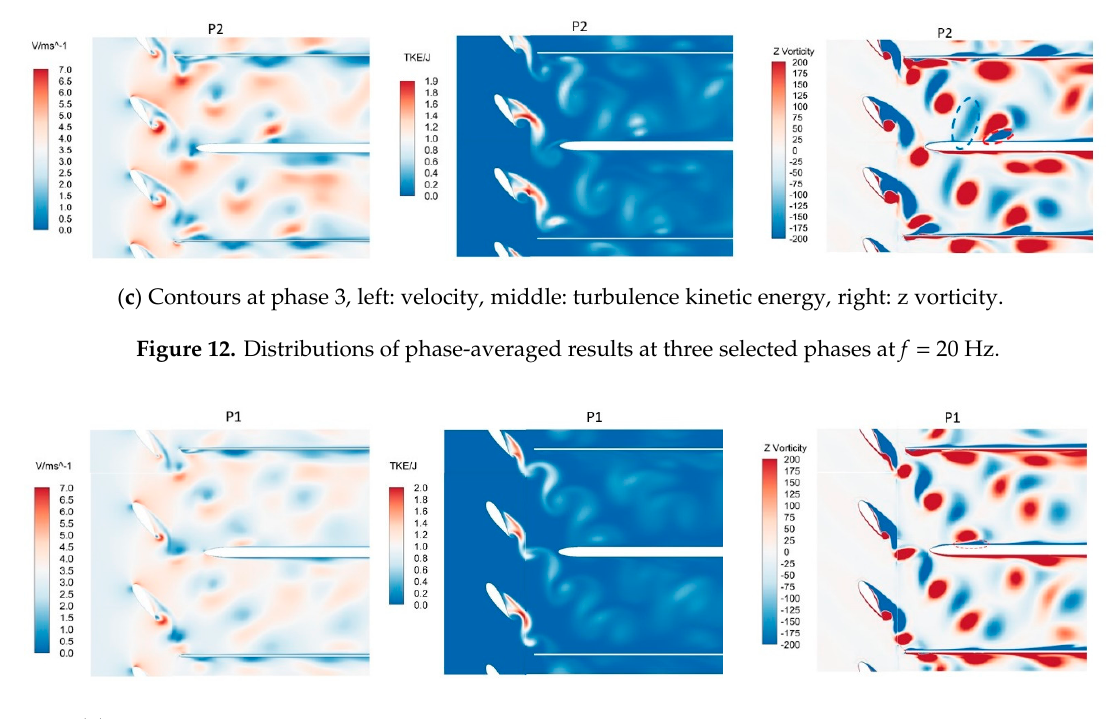
( a ) Contours at phase 1, left: velocity, middle: turbulence kinetic energy, right: z vorticity.